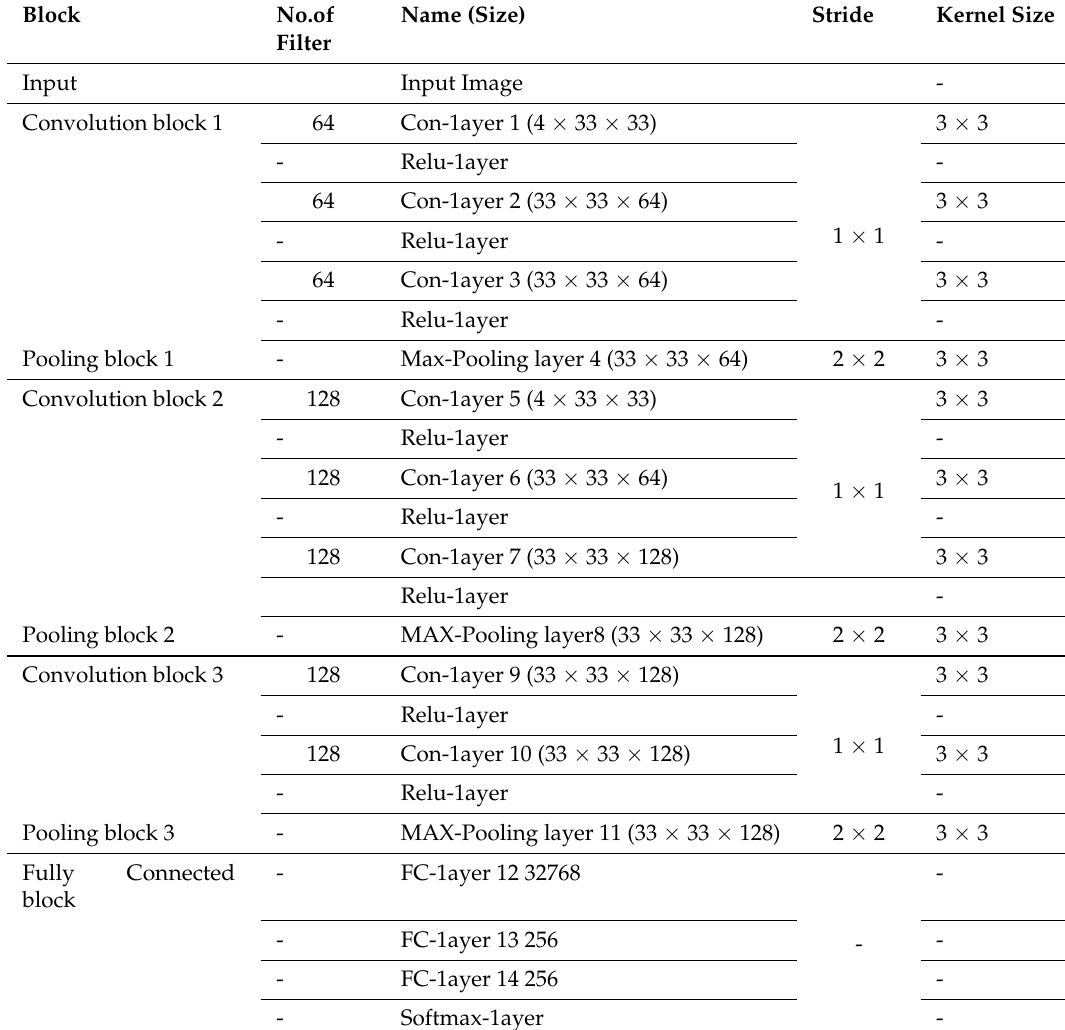
Table 3. Detail of the proposed patch-wise model architecture of Convolutional Neural Network (CNN): In inputs, the first dimension refers to the number of channels and the next two are the size of patch and feature maps,